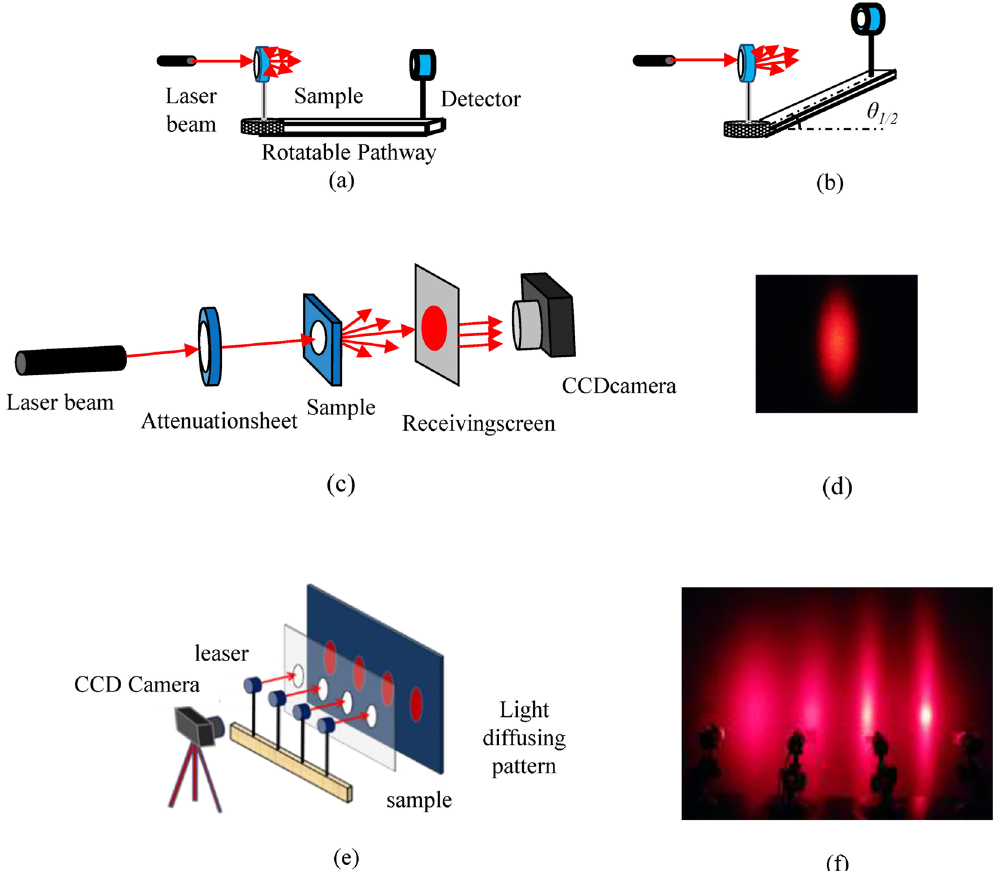
Figure 2. ( a ) The diagram of the scattering angle testing setup. ( b ) Schematic diagram of seeking out the half angle. ( c ) The diagram of the diffusing pattern measuring setup. ( d ) The example of a diffusing pattern. ( e ) The diagram of multi-source scattering pattern test platform and ( f ) the example of multi-source light-scattering